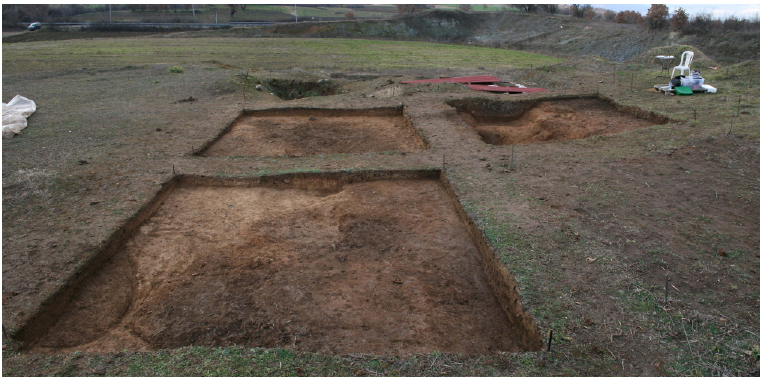
Figure 1. The rescue excavation at Idomeni in 2015 (archive of the Ephorate of Antiquities of Kilkis, photo Stamatis Chatzitoulousis).